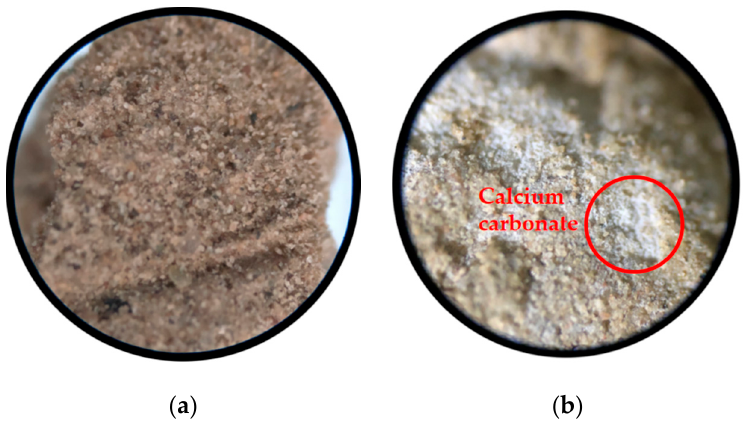
Figure 10. Images of the soil under an optical microscope: ( a ) untreated and ( b ) EICP + glutinous rice powder.